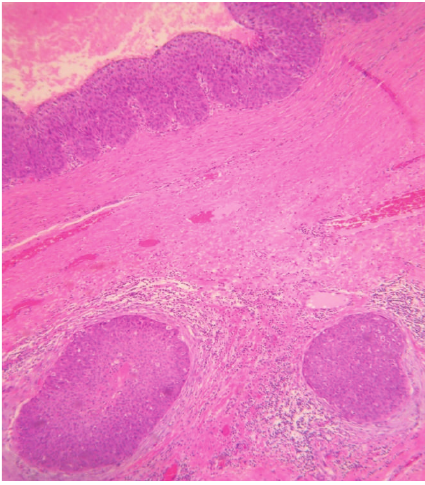
Figure 5: Photomicrograph showing epithelial cell nests in the stroma with desmoplastic reaction (H and E, ×